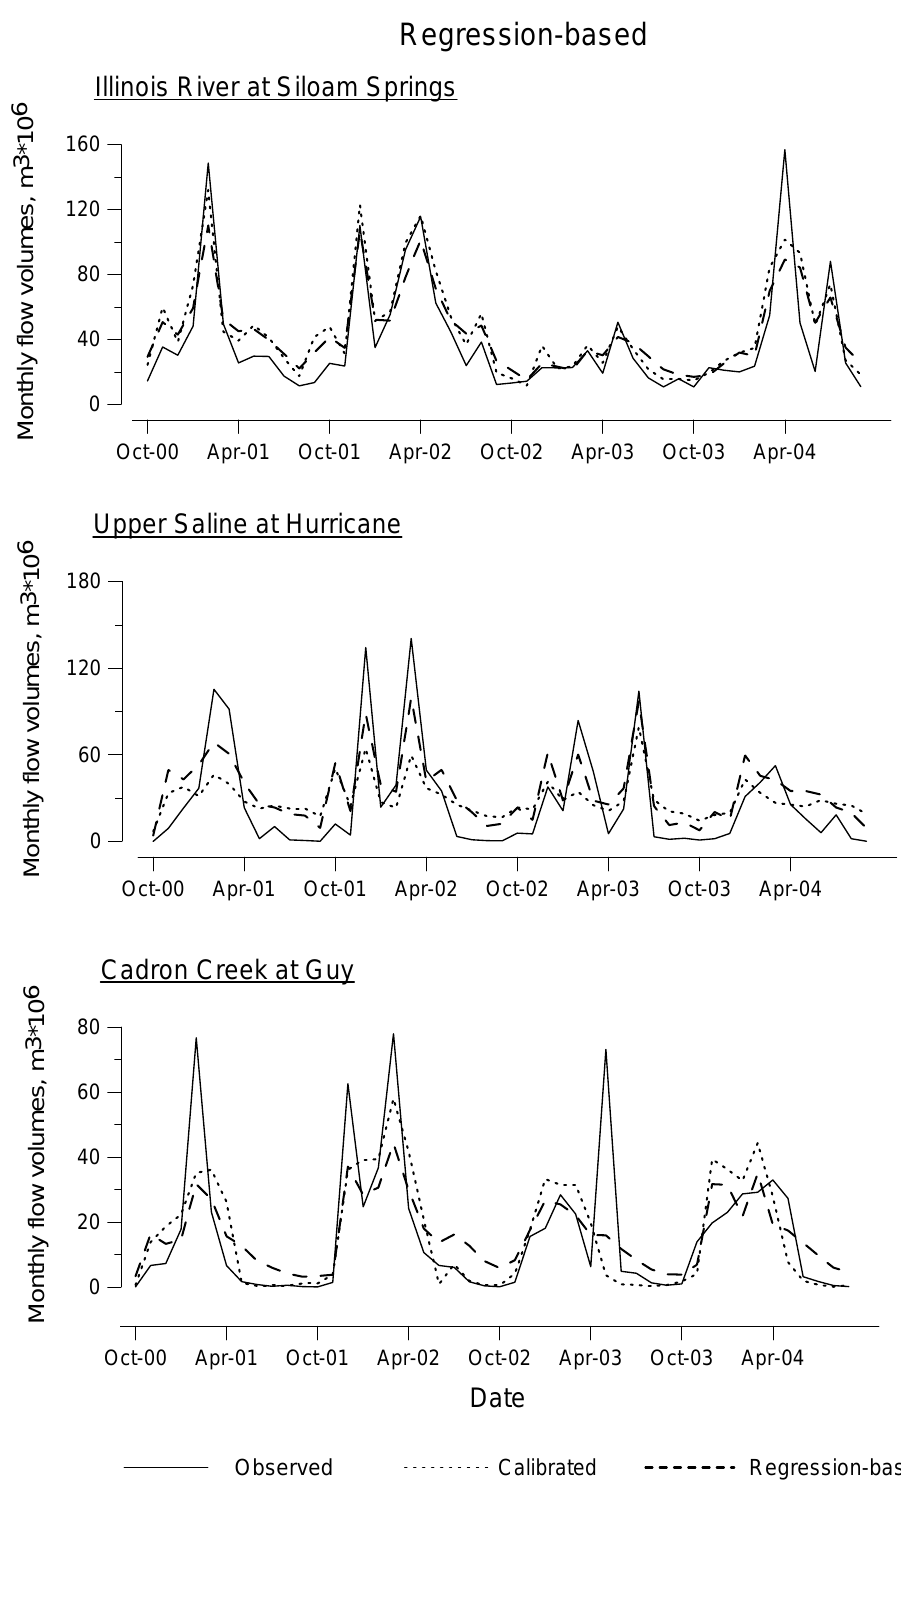
Figure 4 A comparison between regression-based and calibration-based stream flow hydrographs for selected stations within the test watersheds for the period October 2000– September